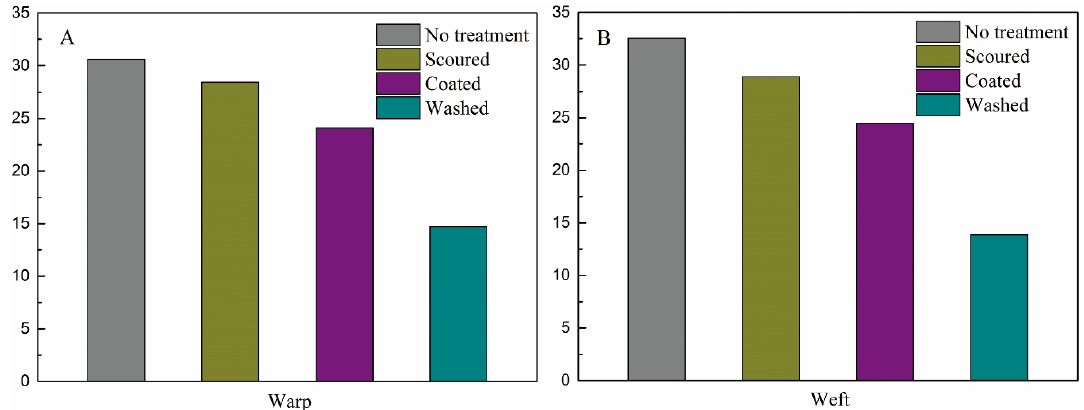
Figure 6. Tearing strength of control sample, scoured, coated, and washed samples (104 washing cycles, 65 o C with nonionic detergent but without bleaching agent); warp ( A ) and weft ( B ).